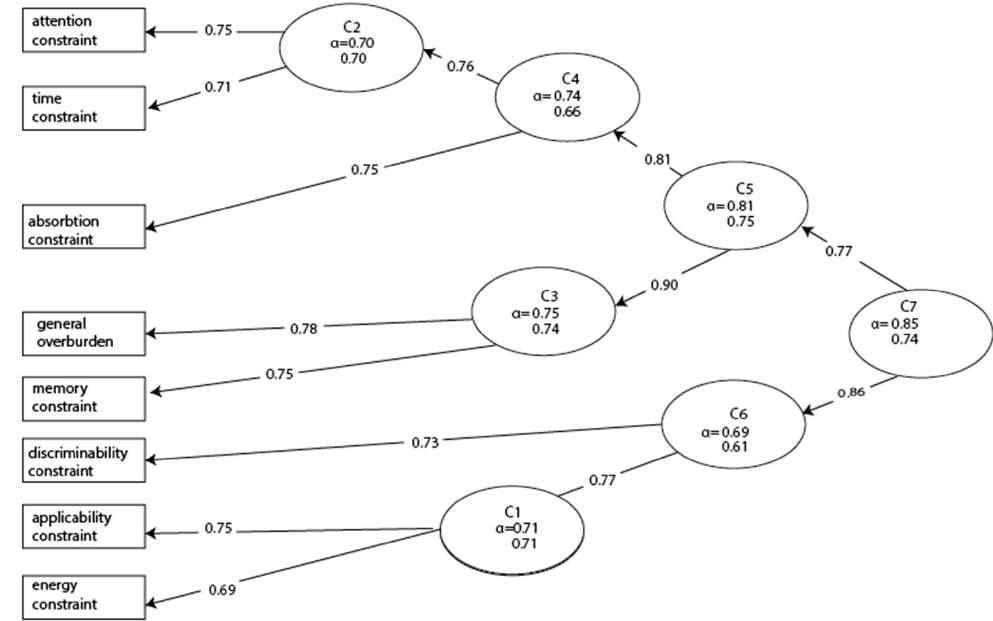
Figure 4. Rooted dendritic structure of